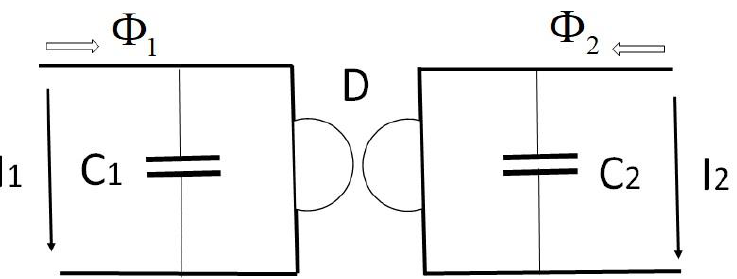
Figure 3. Gyrator with parameter D , input parameters I 1 , Φ 1 , output parameters I 2 , Φ 2 , information capacitors C 1 , C 2 , I 1 = I S ( u ) , Φ 1 = Φ S ( u ) , I 2 = I R ( u ) and Φ 2 = Φ R ( u )